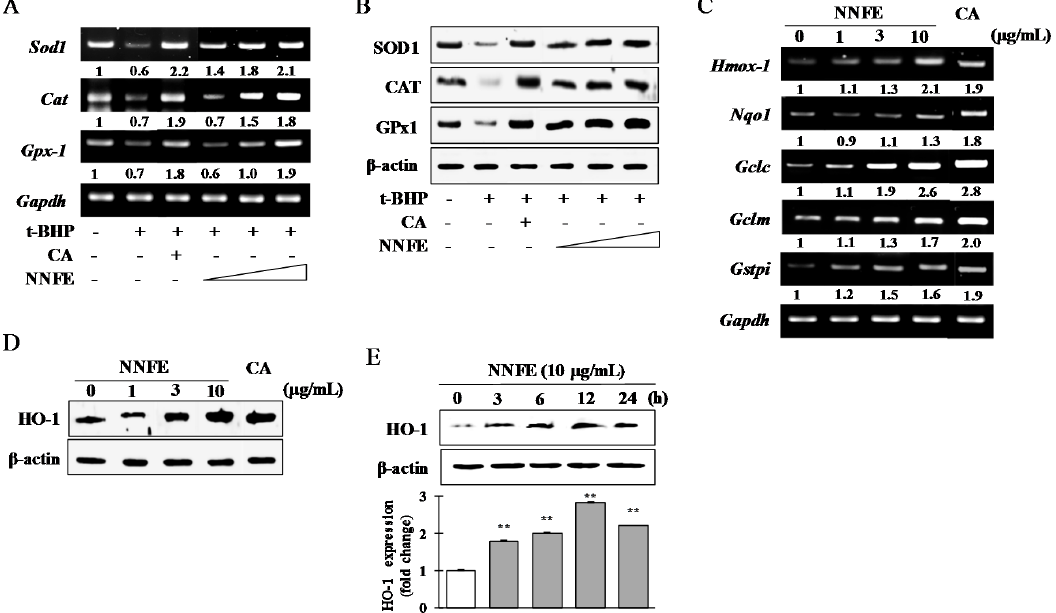
Figure 4. Analysis of primary and phase II antioxidant and detoxifying enzymes. RAW 264.7 cells were pretreated for 12 h with NNFE followed by 12 h treatment with 100 μ M t -BHP. Primary antioxidant enzyme mRNA expression ( A ) and protein expression ( B ) were analyzed by reverse transcription-polymerase chain reaction (RT-PCR) and western blot, respectively. NNFE (1, 3, and 10 μ g/mL) was applied from left to right. RAW 264.7 cells were pretreated for 24 h with NNFE. The mRNA of phase II antioxidant and detoxifying enzymes ( C ) were measured by RT-PCR. The effect on heme oxygenase 1 (HO-1) protein levels in a concentration-dependent ( D ) and time-dependent ( E ) manner was analyzed by western blot. The symbol “**” indicates statistical significance compared to control as determined by one-way ANOVA (** p < 0.01). CA: Caffeic acid 5 μ M. SOD1: superoxide dismutase 1; CAT: chloramphenicol acetyl transferase; GPx1: glutathione peroxidase 1. ( − ): no treatment (+): treatment with t -BHP, white triangle: concentration low to high.